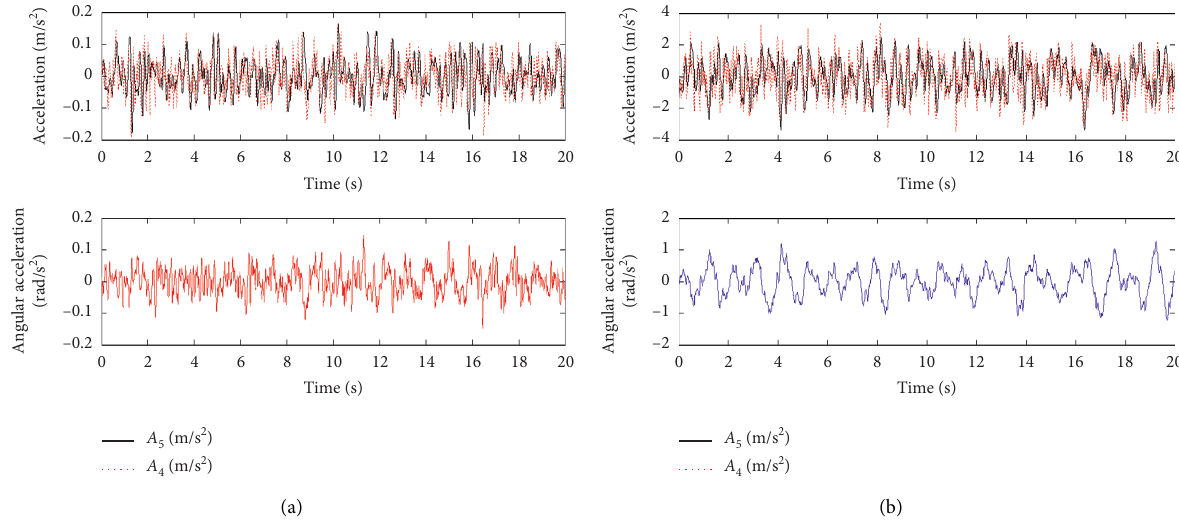
Figure 9: Responses of accelerations A of half vehicle system coupling with the HNES model while the excitation is random road inputs n and the velocity of vehicle is 1.1256m/s (a) and 20m/s (b).